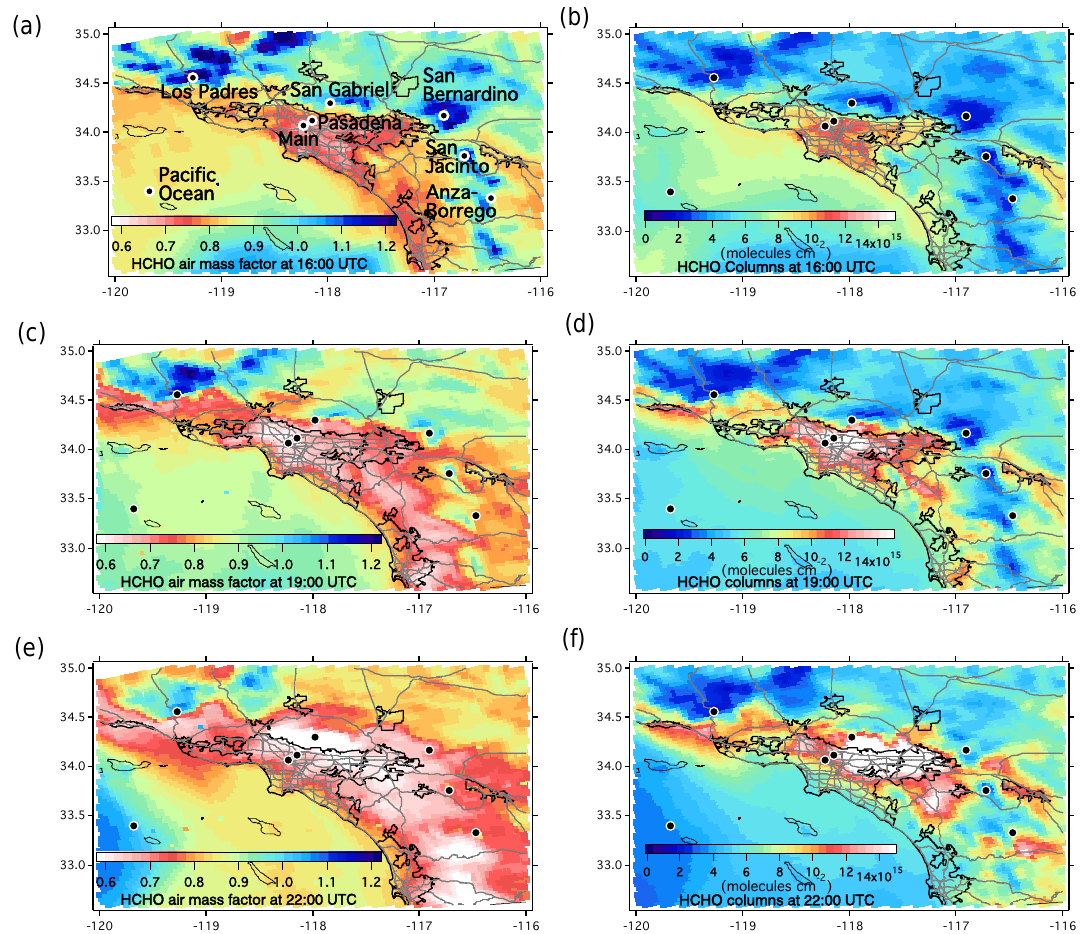
Figure 3. The spatial distributions of air mass factors from the radiative transfer model calculations (a, c, e) and HCHO columns (b, d, f) in the LA Basin at 16:00UTC (a, b) , 19:00UTC (c, d) , and 22:00UTC (e, f) on 4 May 2010. The black filled circles are included as points of further investigations, representing background, urban cores, and downwind